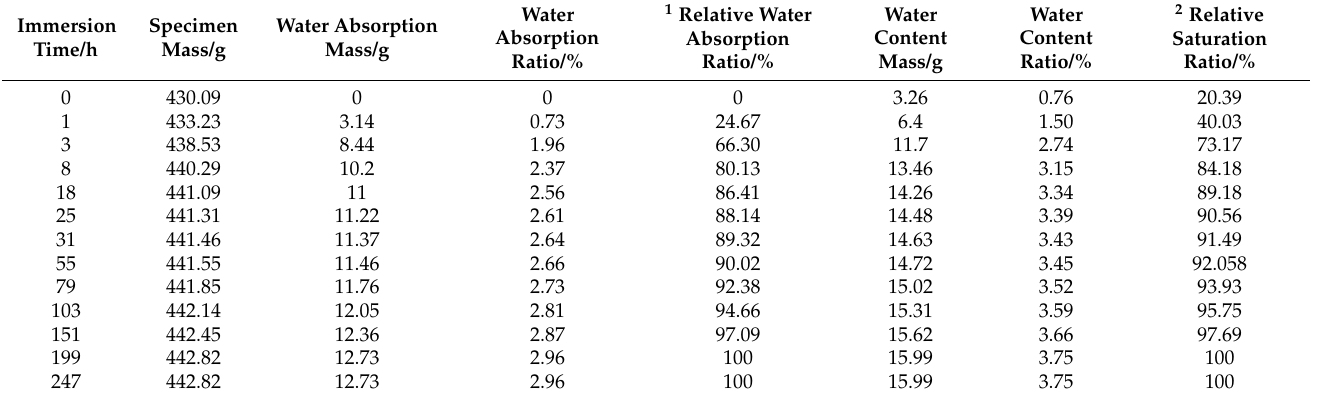
Table 3. Water absorption of the φ 50 mm × 100 mm concrete specimens immersed for different times and placed in a dry room at normal temperature for 9